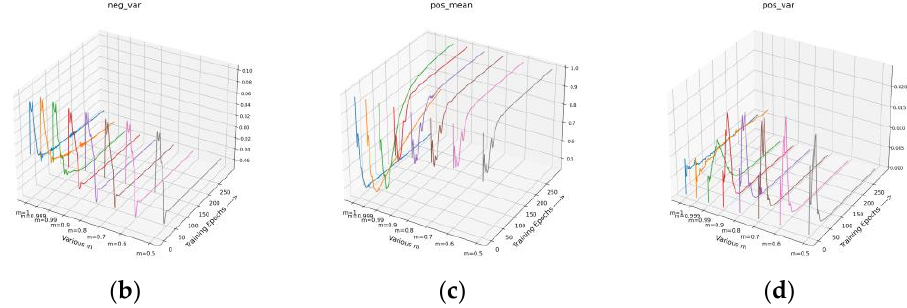
Figure 20. Similarity statistics of various 𝑚 in SCL training on the Chikusei dataset: ( a ) mean of negative similarity; ( b ) variance of negative similarity; ( c ) mean of positive similarity; ( d ) variance of positive similarity. Different colors corresponds to different values of 𝑚 .